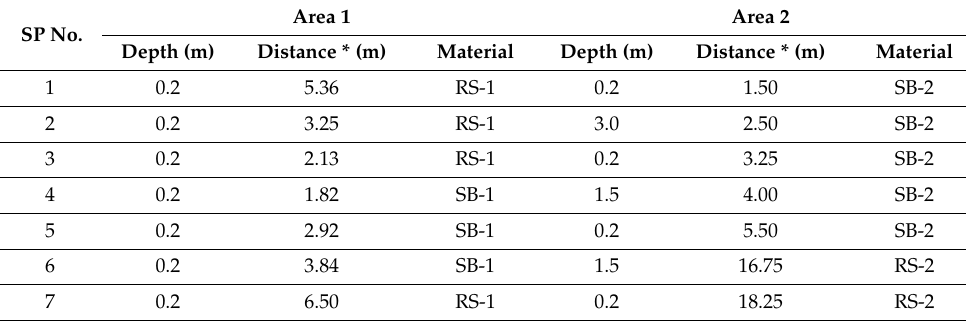
Figure 2. Site instrumentation ( a ) Area 1 and ( b ) Area 2. The numbers represent the SP in Table 3. Table 3. SP distribution in Area 1 and Area